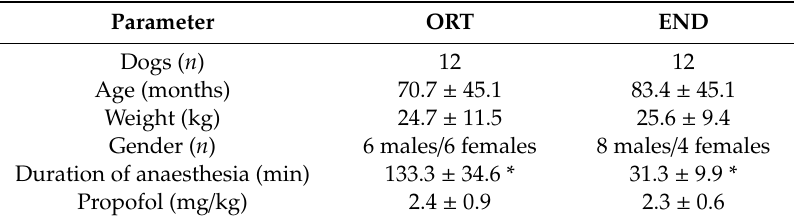
Table 1. Demographic data of dogs included in the study undergoing orthopaedic surgery (ORT) or endoscopic examination (END). Data are reported as mean ± standard deviation (SD). * Statistically significant di ff